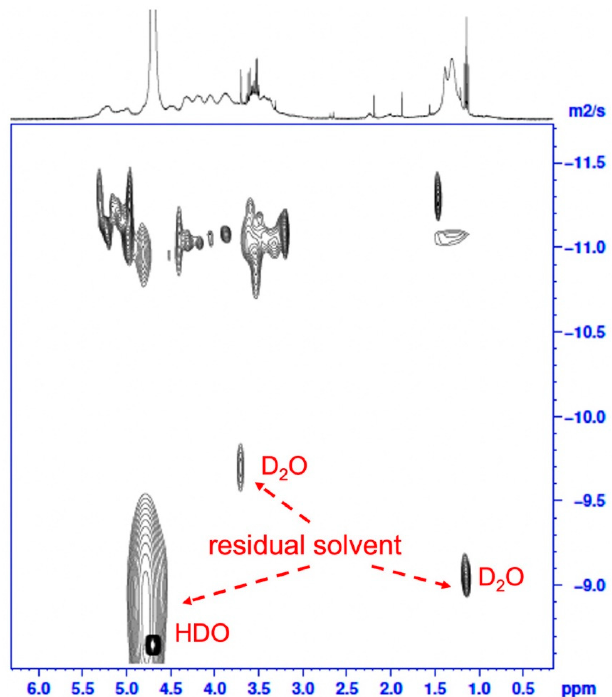
Figure 1. The two-dimensional DOSY spectrum of AdSP. The X -axis corresponds to the chemical shift in classic 1 H NMR, and the Y -axis corresponds to the diffusion shift in classic 1 H NMR, and the Y -axis corresponds to the diffusion dimension.